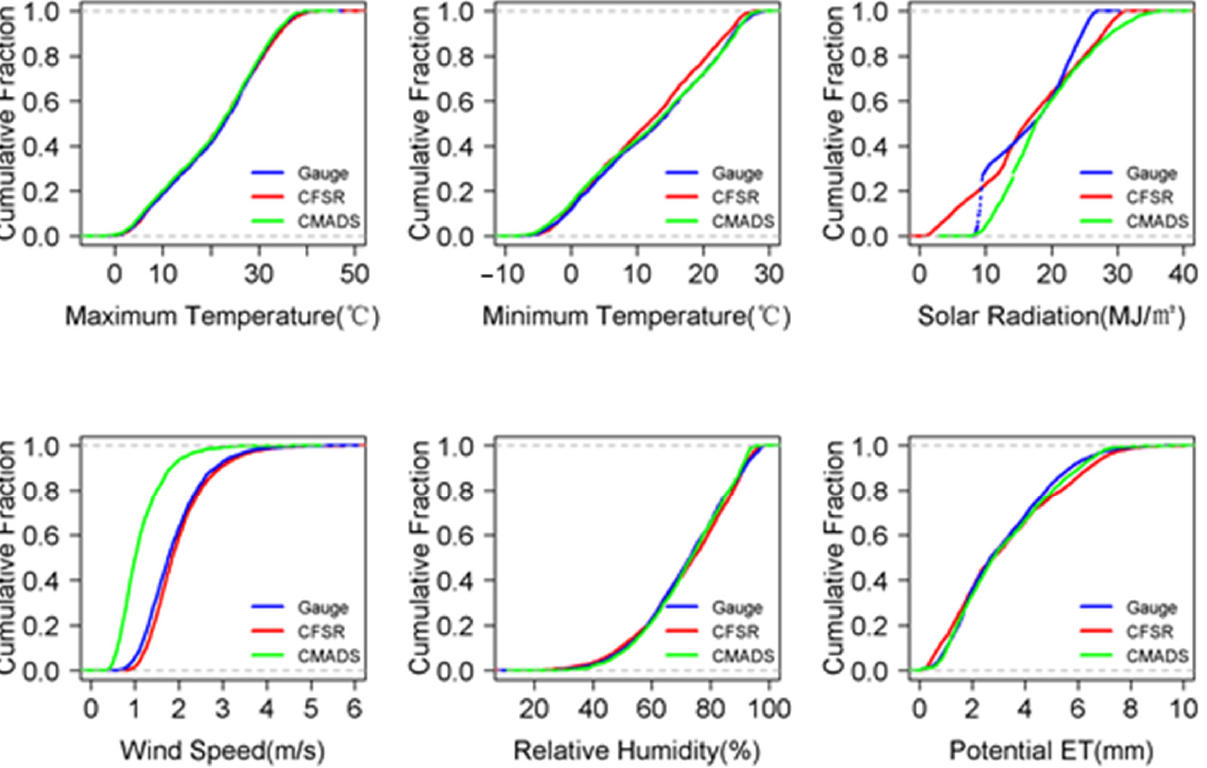
Figure 5. The cumulative fraction of daily maximum and minimum air temperature, solar radiation, wind speed, relative humidity, and potential ET from three different datasets (Gauge, CFSR, and CMADS) at the watershed scale during 2009–2014.